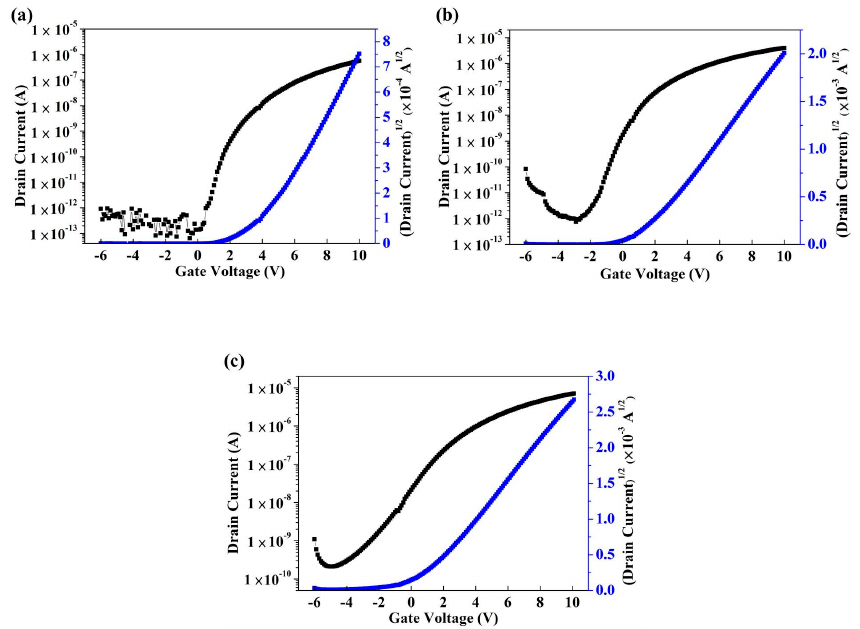
Figure 5. Transfer characteristics of IGO TFTs with different deposition powers of In 2 O 3 . ( a ) Sample A: 50 W, ( b ) sample B: 60 W, and ( c ) sample C: 70 W.